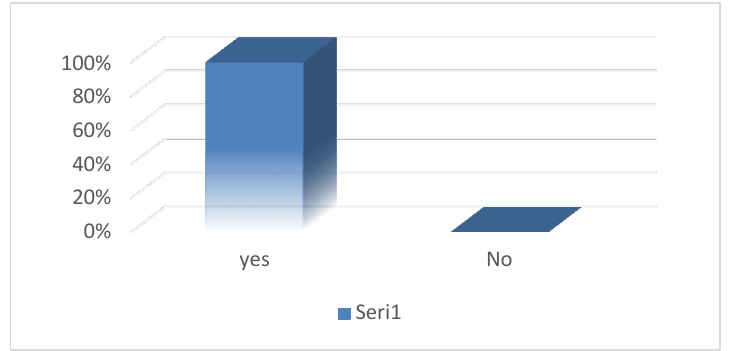
Figure 7: Answers on“Have you seen any advertisement of ANY Coca Cola drinks?”